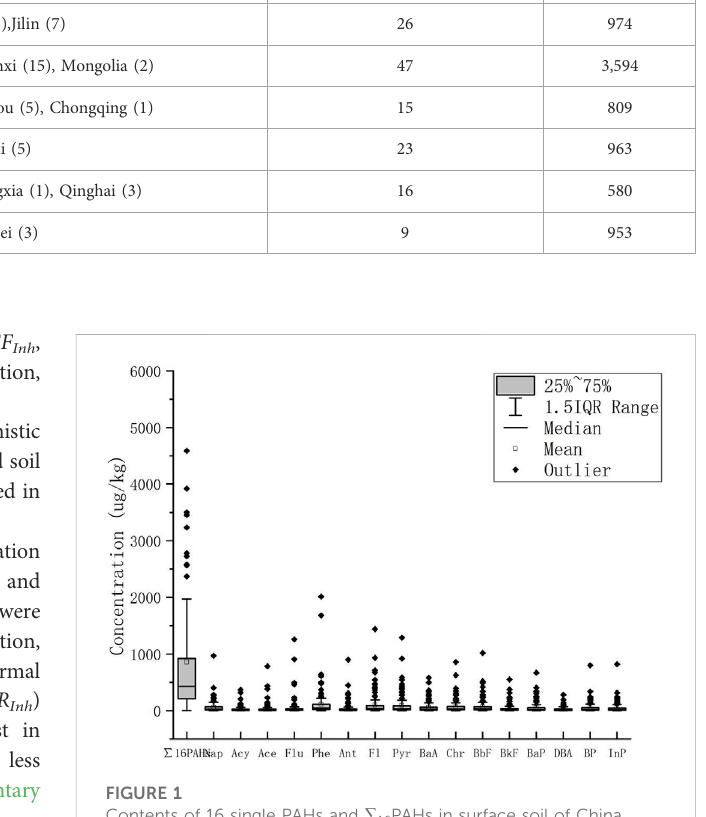
Contents of 16 single PAHs and (cid:1) 16 PAHs in surface soil of